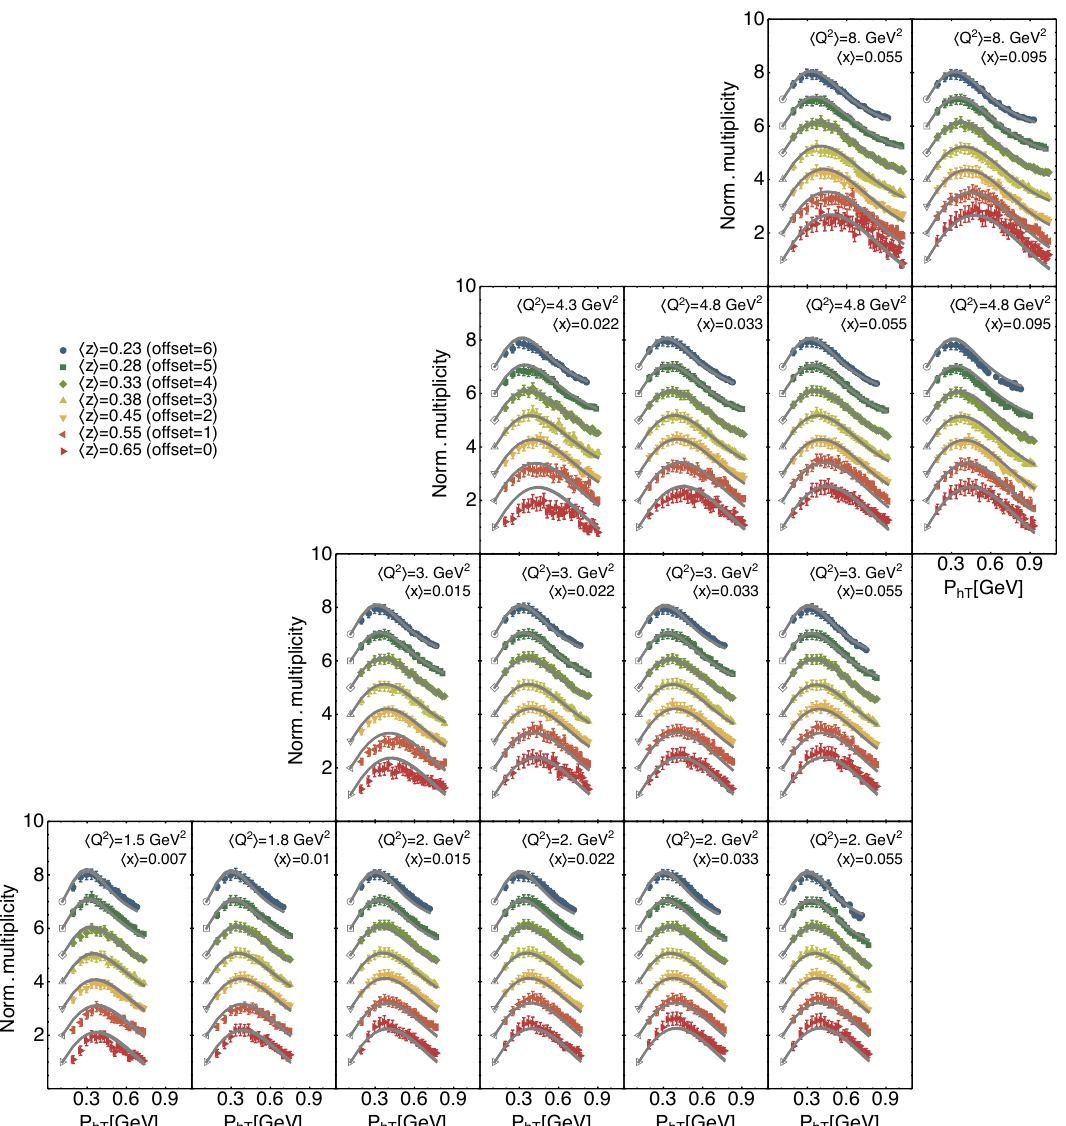
Figure 6 . Compass multiplicities for production of positive hadrons ( (cid:25) + ) off a deuteron for different x , z , and Q 2 bins as a function of the transverse momentum of the detected hadron h i h i h i P hT . Multiplicities are normalized to the first bin in P hT for each each z bin has been shifted by an offset indicated in the h i